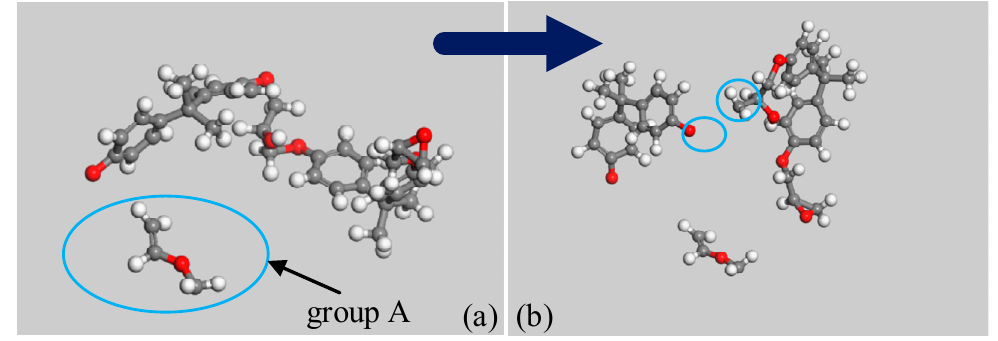
Figure 3. PEP decomposition process. ( a ) The first decomposition process; ( b ) The second decomposition process. Table 2. Activation energy of some carbon-oxygen bonds .